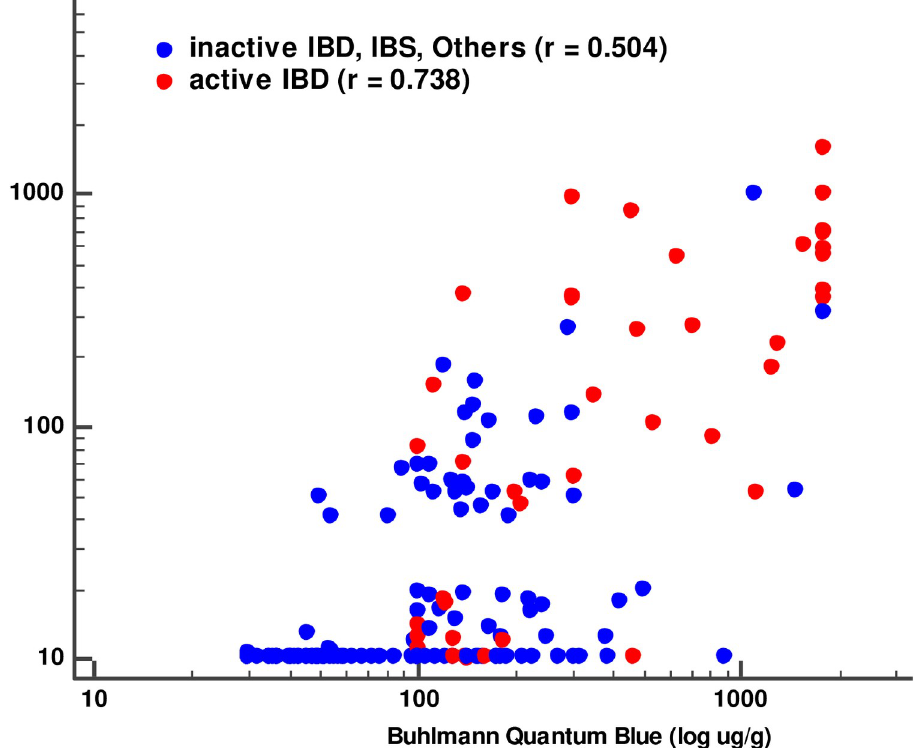
Fig 2. Correlation between fecal calprotectin results by iChroma calprotectin and Buhlmann Quantum Blue assays. The correlation was stronger in patients with active IBD (r = 0.738) than in the other groups (r = 0.504).